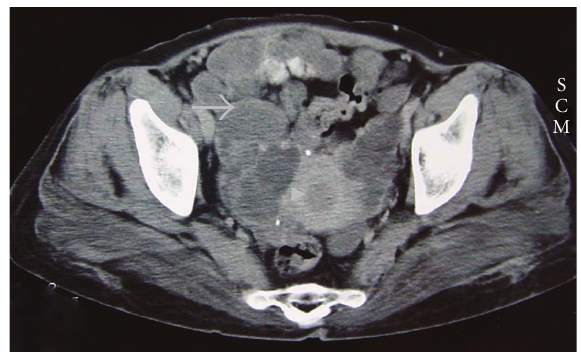
Figure 1: Axial pelvic CT scan demonstrates multiple cystic masses (arrow) in the pelvic cavity and also the uterus (arrowhead).